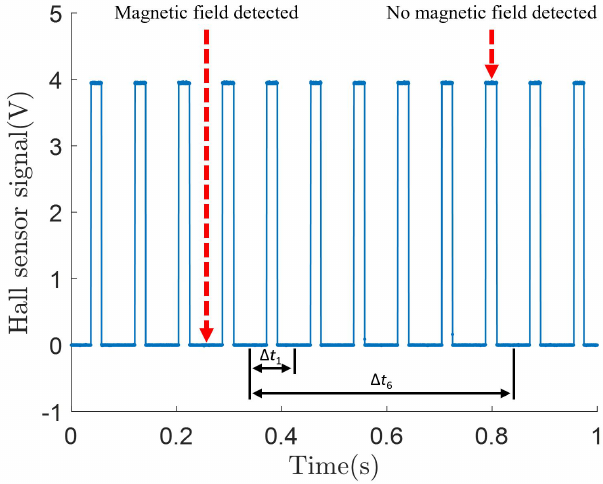
Figure 3. Illustration of the Hall sensor raw output signal when the shaft was rotating constantly at 120 rpm. Each magnetic field detection by the sensor created a voltage drop in the signal.